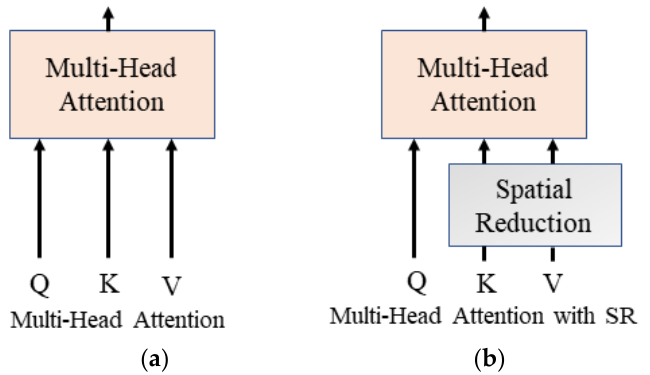
Figure 2. Structure of attention. (( a ) is the multi-head attention of vanilla transformer and ( b ) is the multi-head attention with spatial reduction of